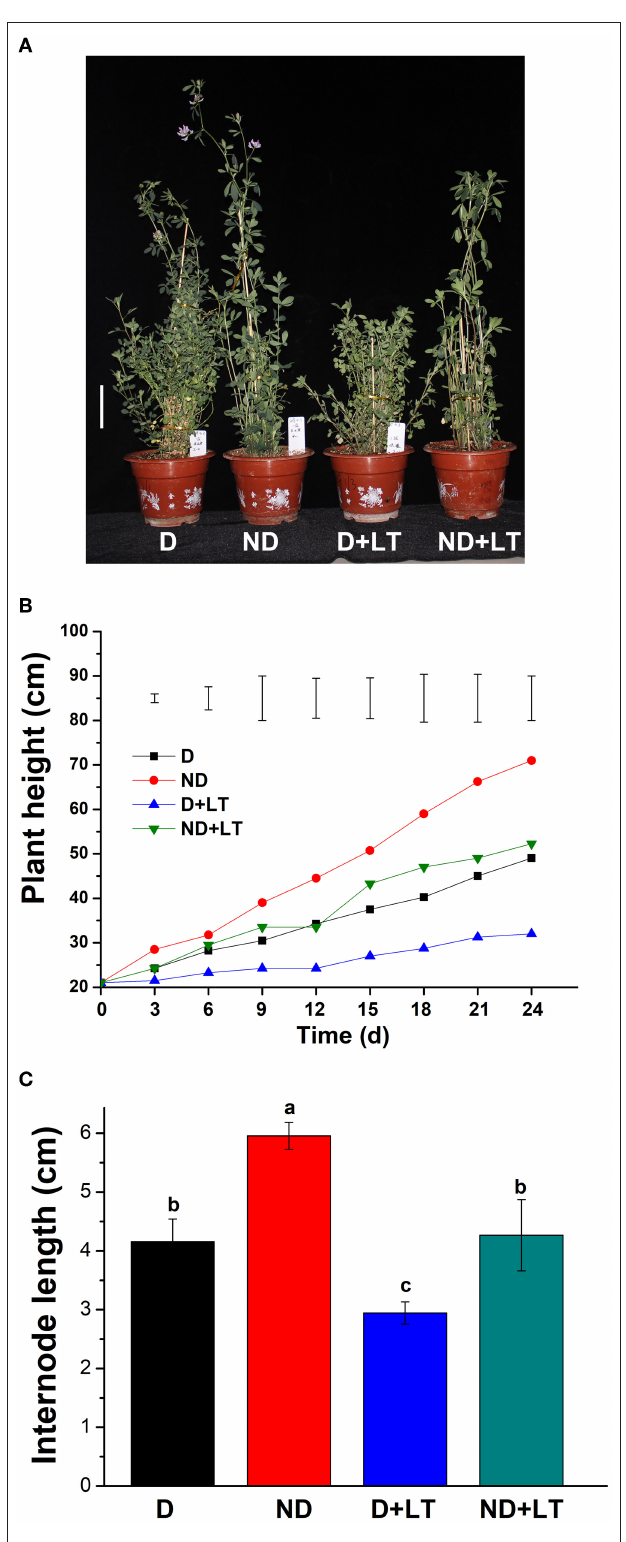
FIGURE 1 | Phenotypic characterization of dormancy and non-dormancy alfalfa cultivars under lower temperature (LT). (A) The phenotype of dormancy (D, Maverick) and non-dormancy (ND, UC-1465) alfalfa varieties under normal